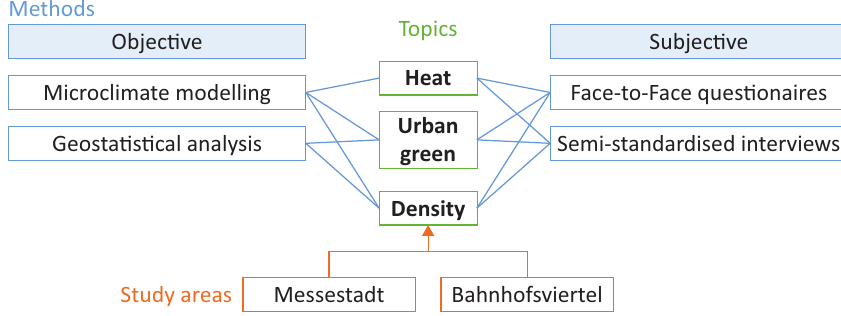
Figure 2. Employed methods and research approach. mal comfort surveys, which usually focus on right‐here‐ right‐now evaluations of current micro‐meteorological parameters (like air temperature, sun, humidity, and wind), this mental mapping method allowed us to cap‐ ture people’s long‐term memory of holistic thermal per‐ ception. All dots were digitised and geocoded using a GIS. Dots referring to larger areas or streets were poly‐ gonised. Based on the resulting layers of dots, coloured heat maps were created using Kernel density estimation with a radius of 15 m (Netek et al., 2018).